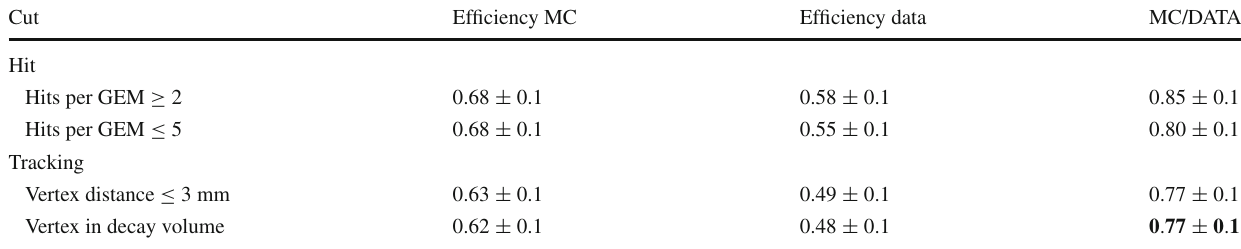
first cut applied being the one in the first row. First two cuts are based exclusively on information coming from the single GEM modules. Last two cuts are based on the tracking procedure